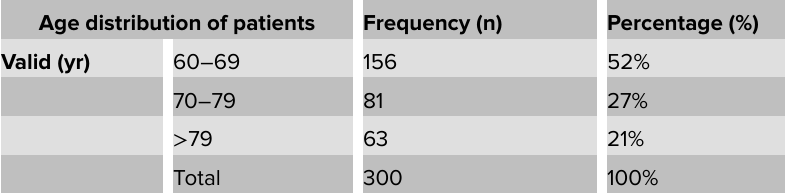
TABLE 1: Demographic details of the patients (age distribution).